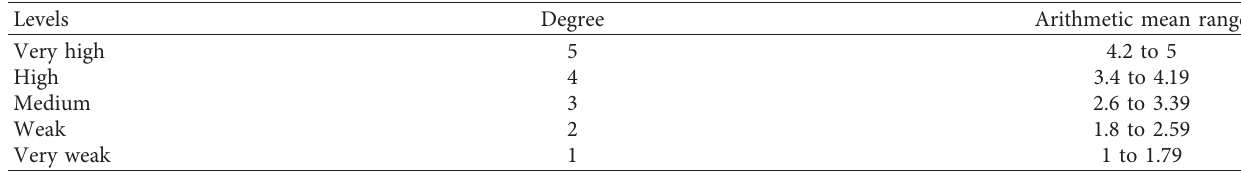
Table 2: Measurement distribution of levels.